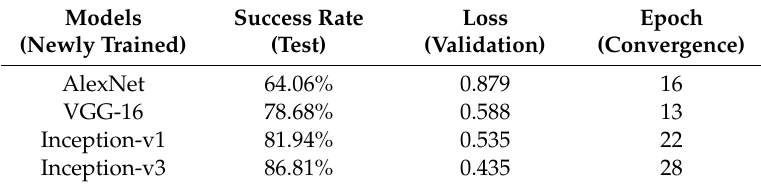
Table 3. Performance of various CNNs newly trained on the dataset with data